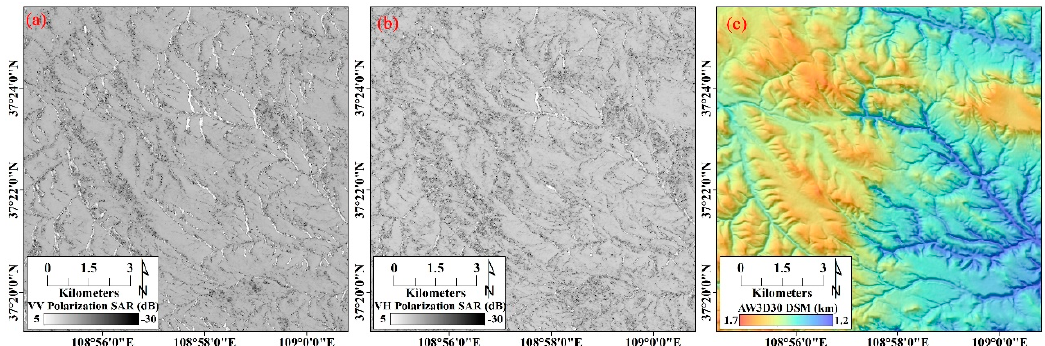
Figure 3. Remote sensing datasets of the study area: ( a ) VV polarimetric backscattering coefficients derived from GRD Sentinel-1A products; ( b ) VH polarimetric backscattering coefficients derived from GRD Sentinel-1A products; ( c ) the digital surface model from AW3D30 DSM products.